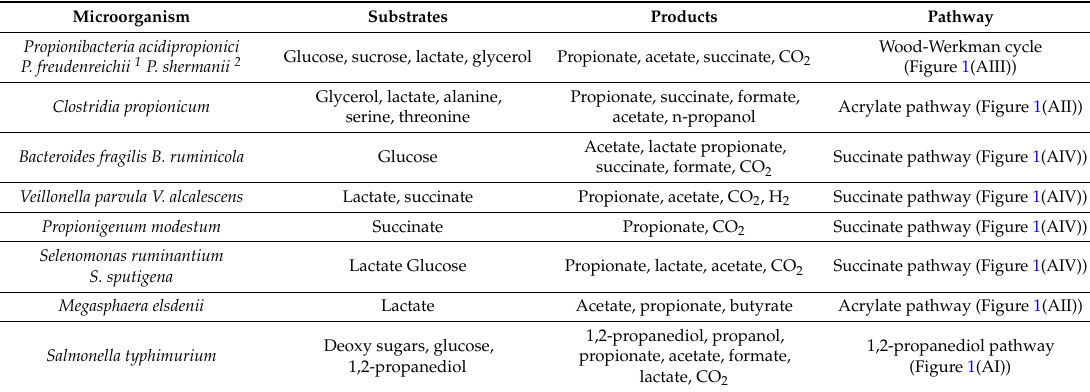
Table 3. Microbial species able to generate propionic acid during